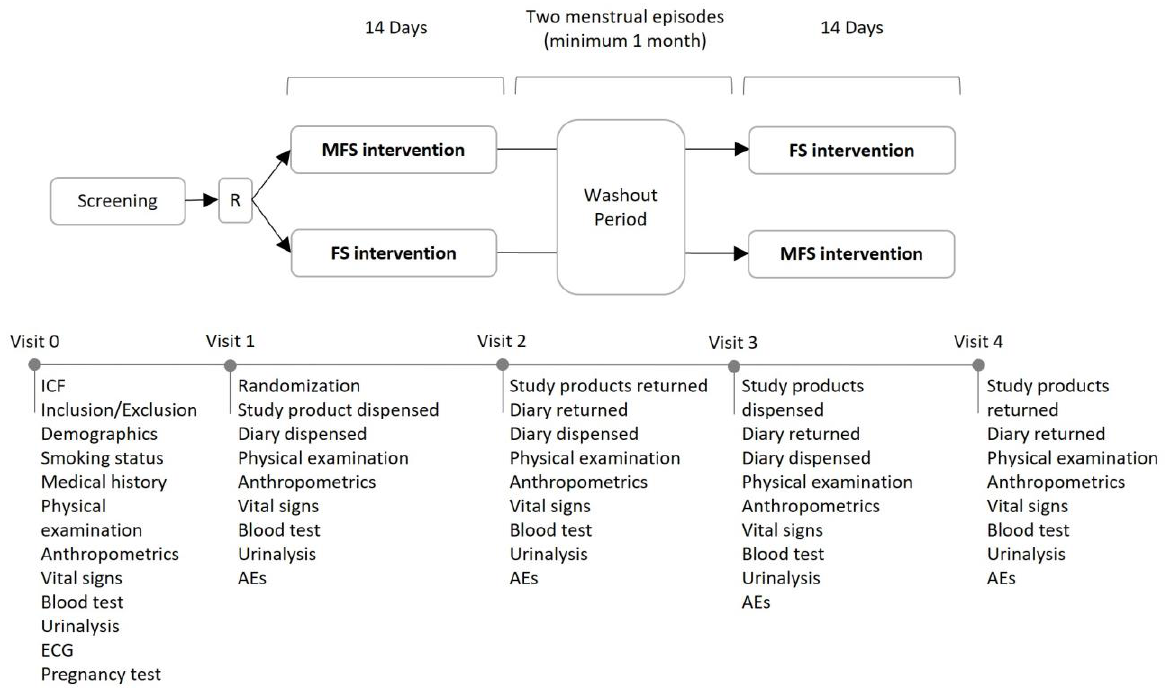
Figure 2. Overview of study design. This was a crossover, randomized, double-blind study. The two intervention phases were separated by washout period. The diary included daily question- naires and product consumption time. (MFS: microencapsulated ferric saccharate, FS: ferrous sul- phate, R: randomization, AEs: adverse events, ICF: informed consent form, ECG: electrocardio- gram).